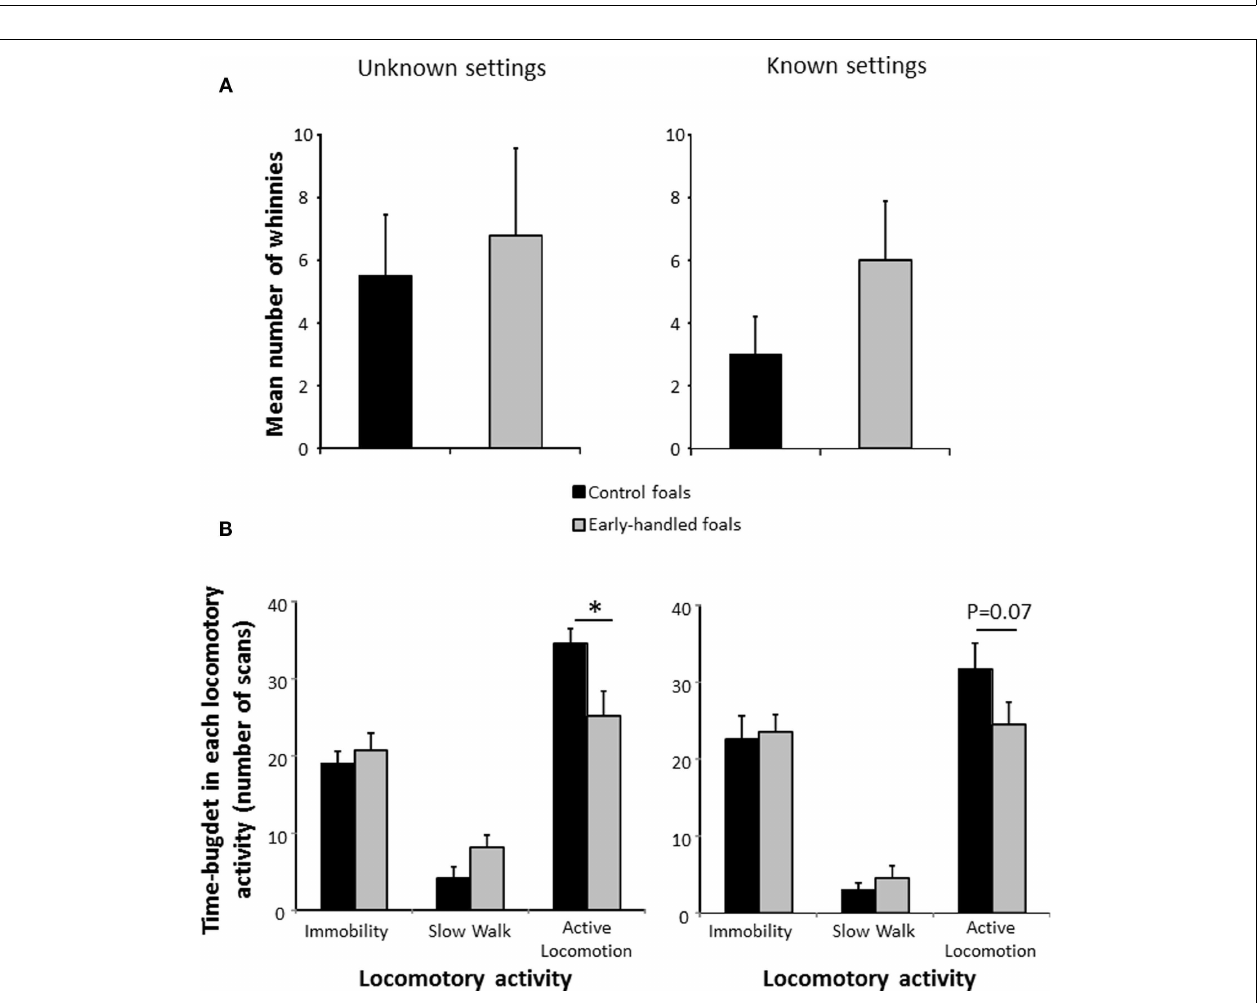
FIGURE 2 | Reaction to novelty of 1-year-old, early handled, and unhandled foals. (A) Mean latency ( ± SEM) before the first contact with the novel object. (B) Mean number ( ± SEM) of scans when the foals performed different forms of locomotor activity.